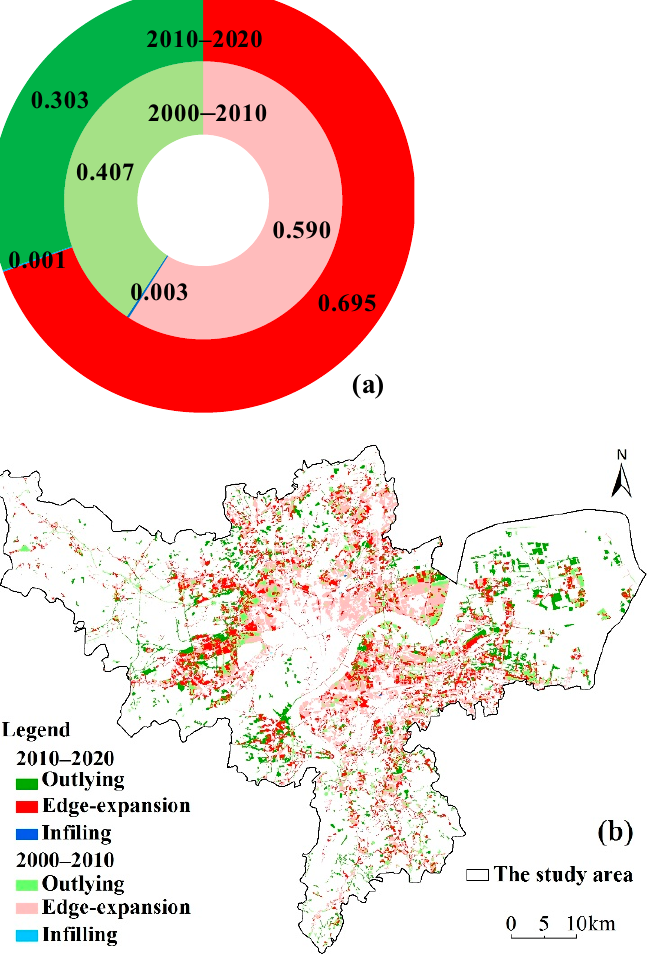
Figure 9. The proportions ( a ) and distribution ( b ) of urban expansion types in Hangzhou City from 2000 to 2020. Table 4. Statistical description of the NLSTs of different expansion types in Hangzhou